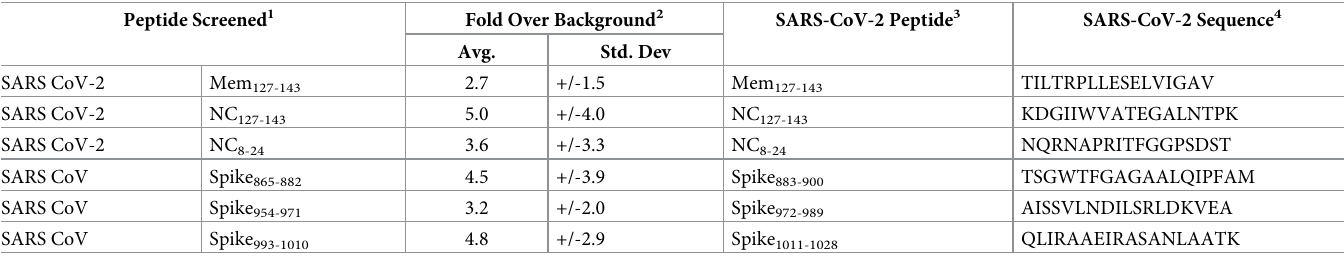
Table 2. Functional identification of SARS-CoV-2 CD4+ T cell epitopes. 1 Screened peptide sequences are named based on the protein they are contained within, fol- lowed by the number of the first amino acid residue of the peptide in the context of the full protein to the last amino acid residue. Peptides within the "Spike" peptide library correspond with SARS-CoV Spike due to library availability. 2 Average fold over background IFN- γ + CD4 + T cells stimulated with listed peptides. Background is defined as the frequency of IFN- γ + CD4 + T cells in a well stimulated with vehicle control. The average and standard deviation is from three independent experiments 3 Analogous